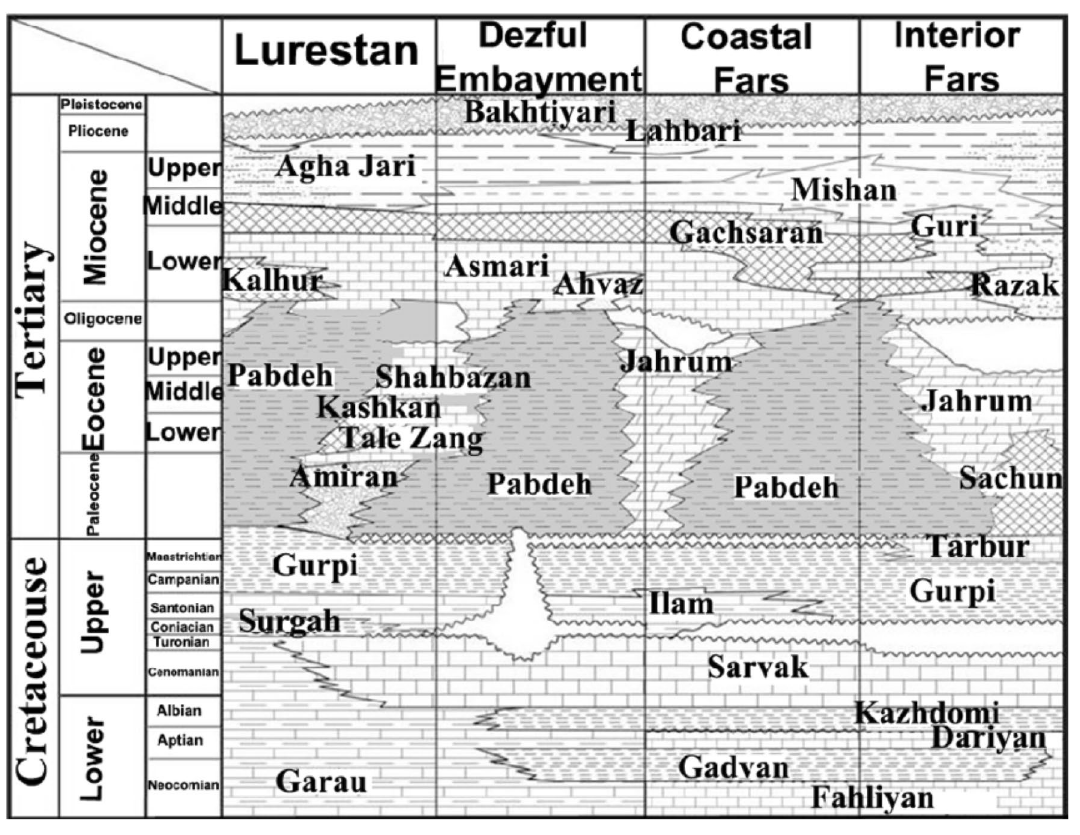
Fig. 1 Stratigraphy of Zagros (Tabatabaei 2017)